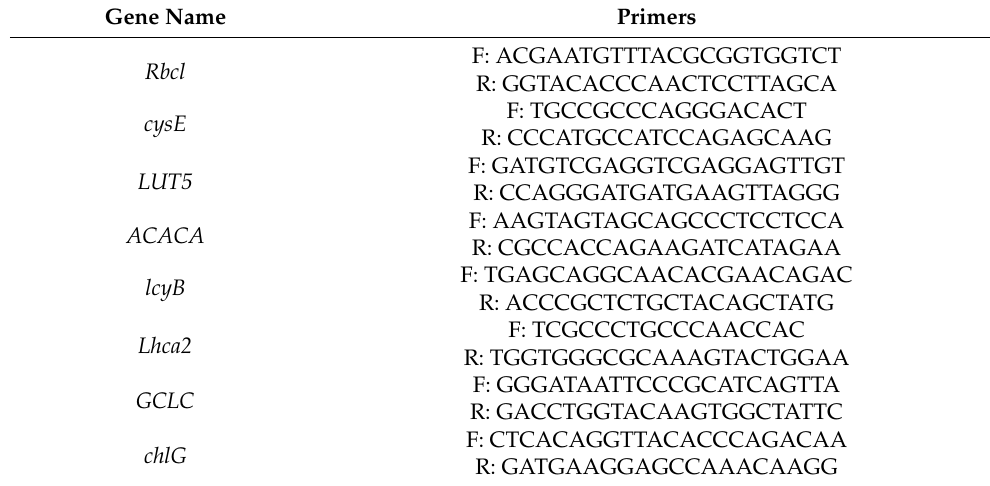
Table 2. List of qPCR genes and